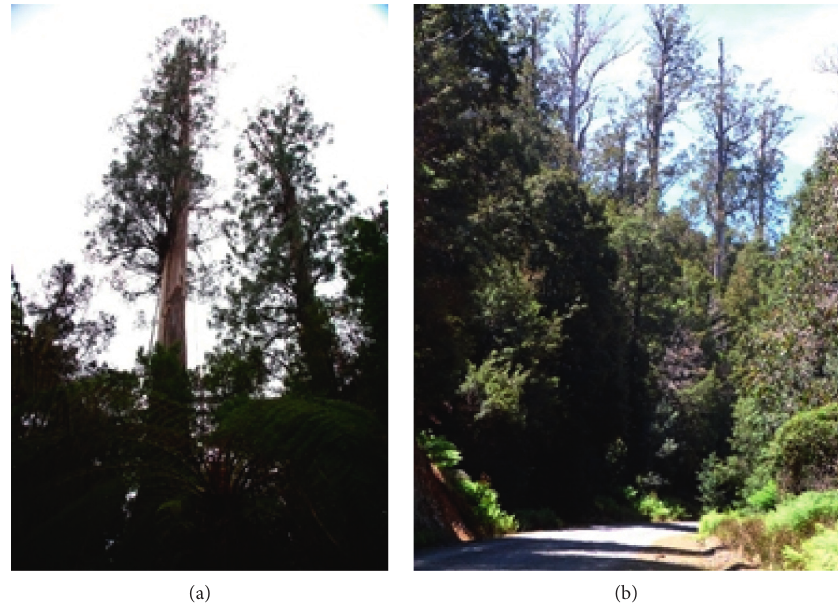
Figure 1: Iconic Tasmanian wet eucalypt forests. The tree on the left (a) is 100m tall. The right-hand side image (b) shows mixed forest consisting of mature tall eucalypts ( Eucalyptus regnans ) and a dense understorey of rainforest species which are about half as tall as the dominant